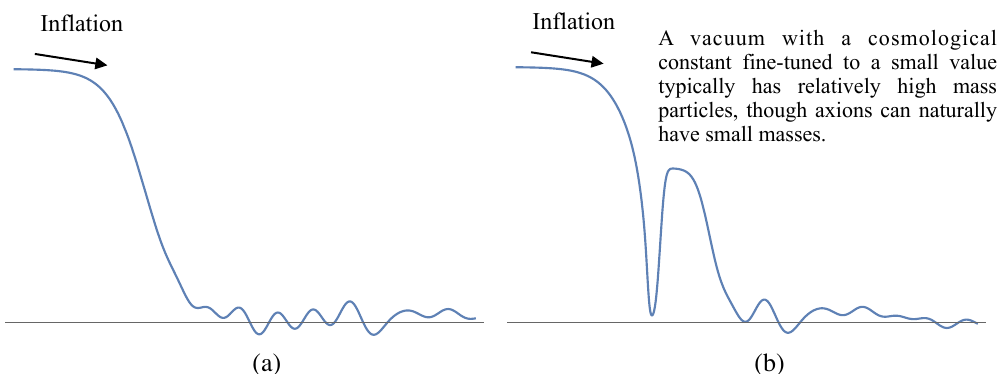
Figure 1 . The left cartoon picture (a) shows the situation where most vacua have a very small cosmological constant; so, after in(cid:13)ation, the universe will roll down to such a low dS vacuum before it has a chance to go to any of the AdS vacua. We argue by examples that such a vacuum has very light bosons. The right cartoon picture (b) shows that if we are allowed to (cid:12)ne-tune free parameters (or by accident), we can also have a vacuum with a very small cosmological constant, so our universe rolls into it. In this case, we typically will get large scalar